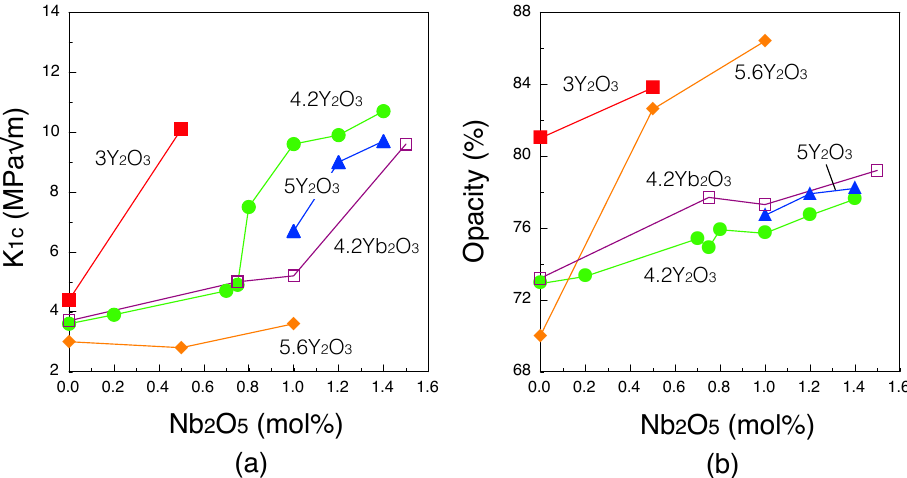
Figure 3. The effect of Nb 2 O 5 content on ( a ) fracture toughness and ( b ) opacity of ZrO 2 -Y 2 O 3 -Nb 2 O 5 (No. 2–5 and 10–22) and ZrO 2 -Yb 2 O 3 -Nb 2 O 5 (No. 28–30).